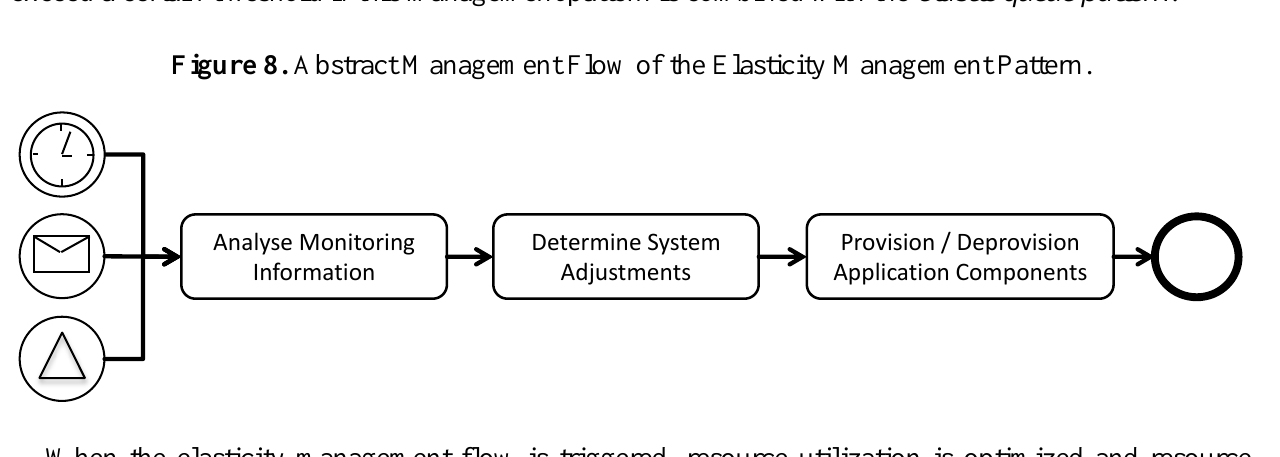
Figure 7. Icon of the Elasticity Management Pattern.